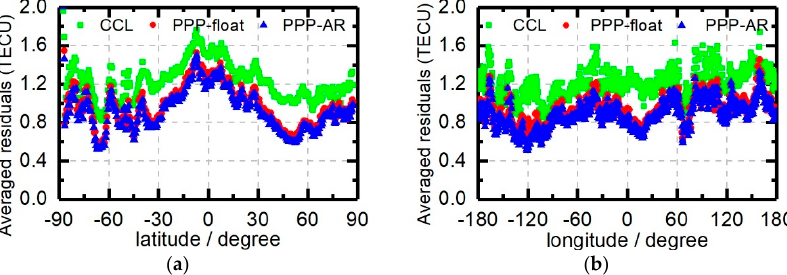
Figure 8. Latitude-dependent averaged residual distributions ( a ) and longitude-dependent averaged residual distributions ( b ) for the CCL, PPP-float, and PPP-AR methods on DOY 100,